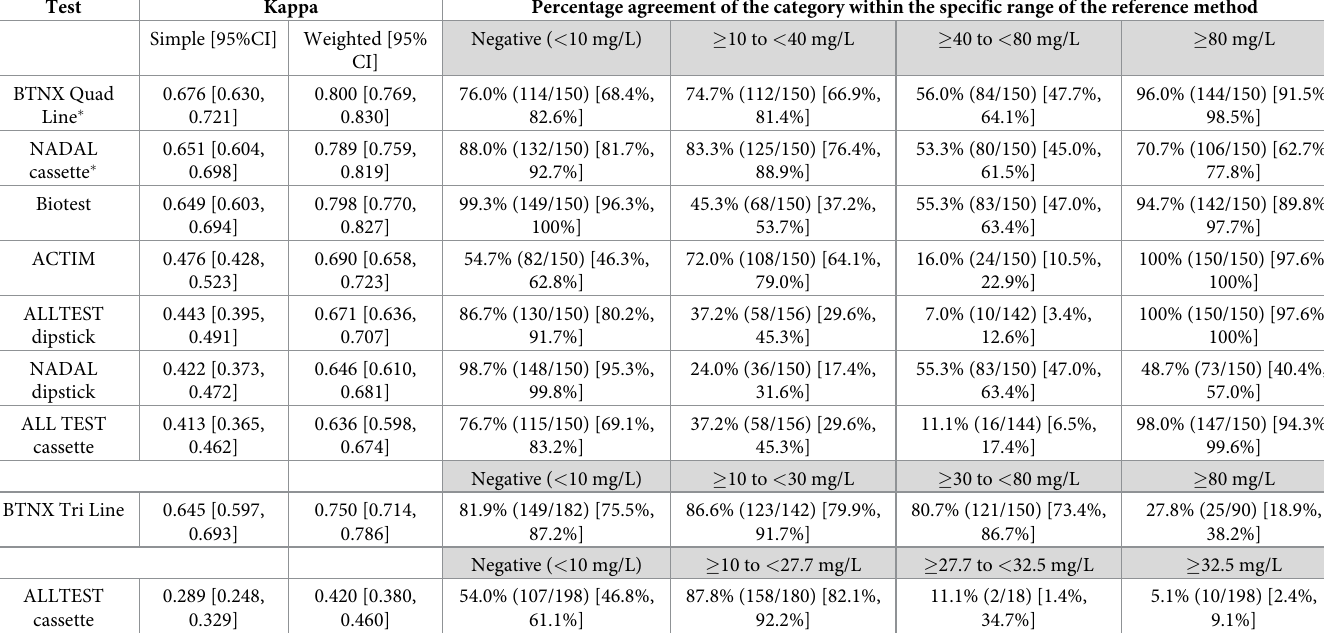
Table 4. Results of the method comparison for semi-quantitative